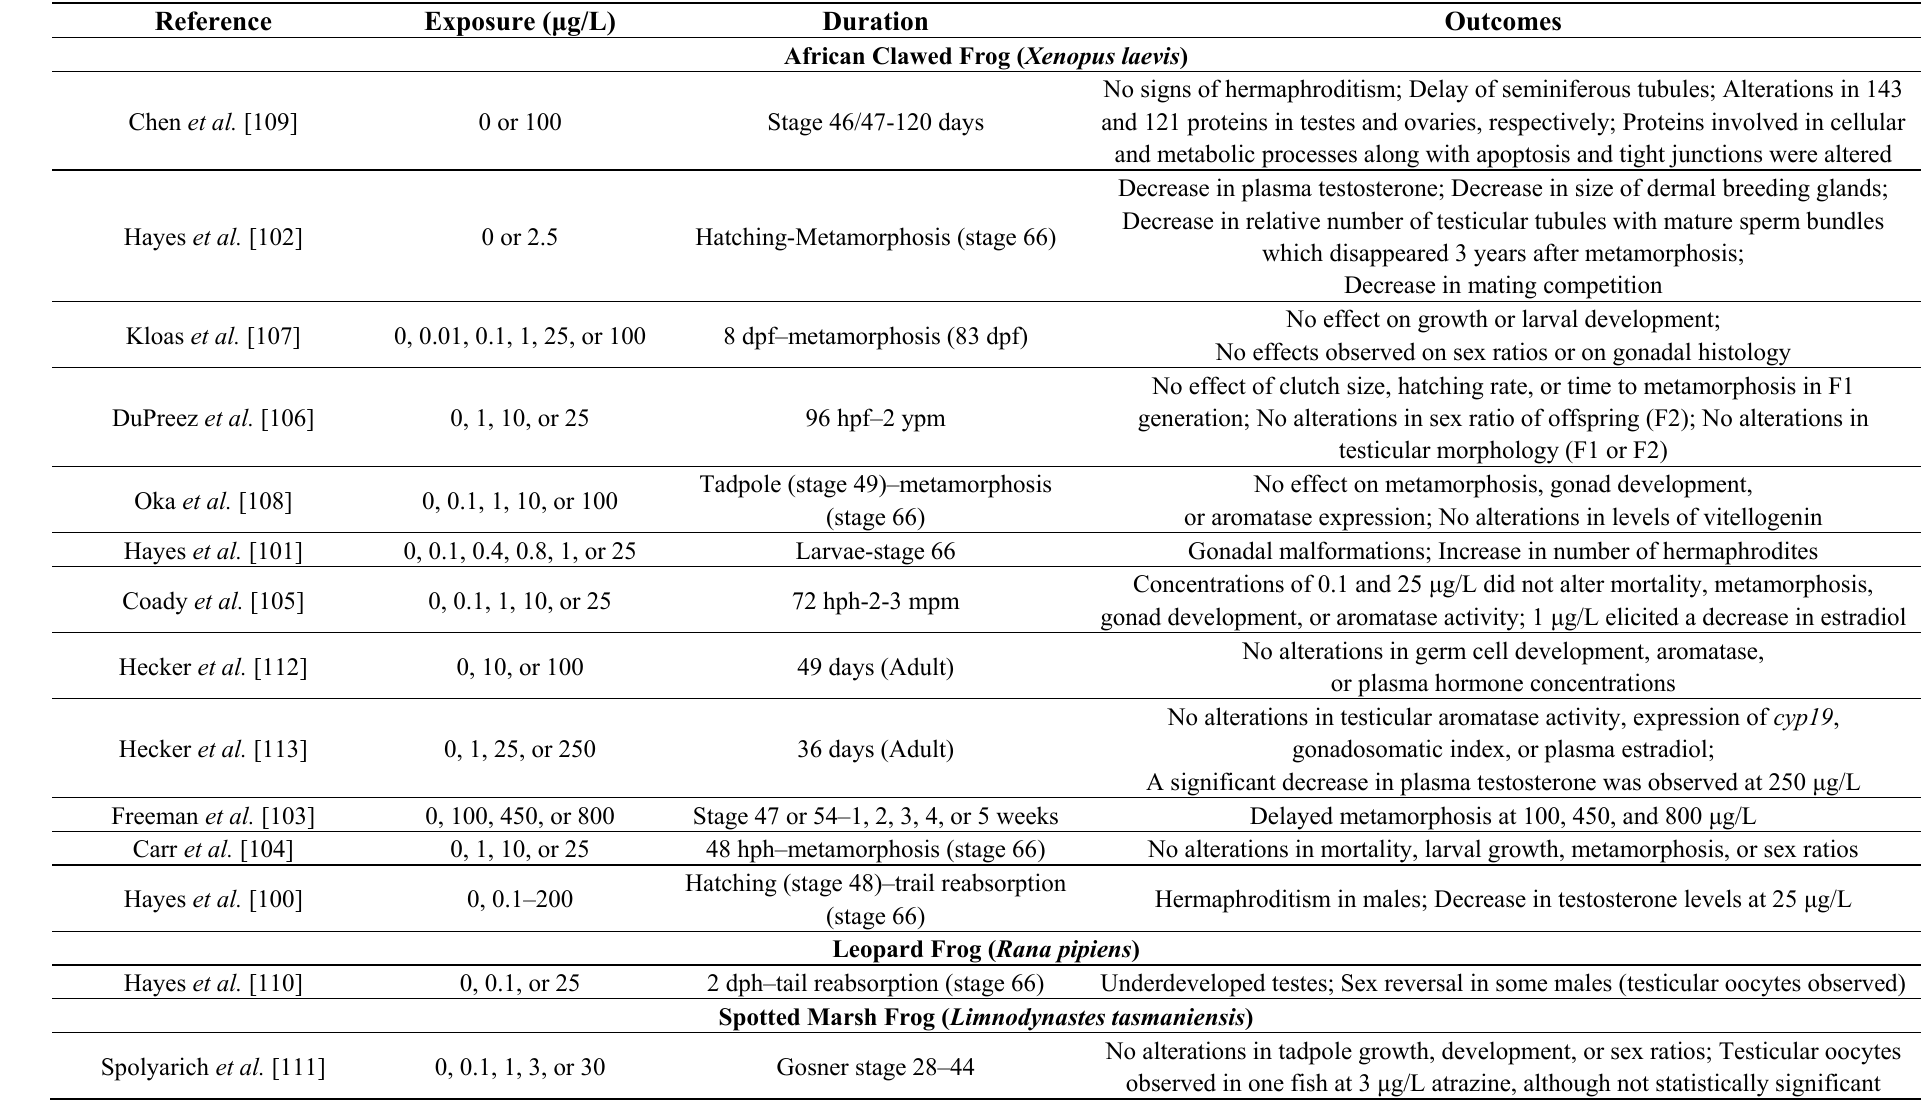
Table 3. Reproductive effects of atrazine in anuran and fish